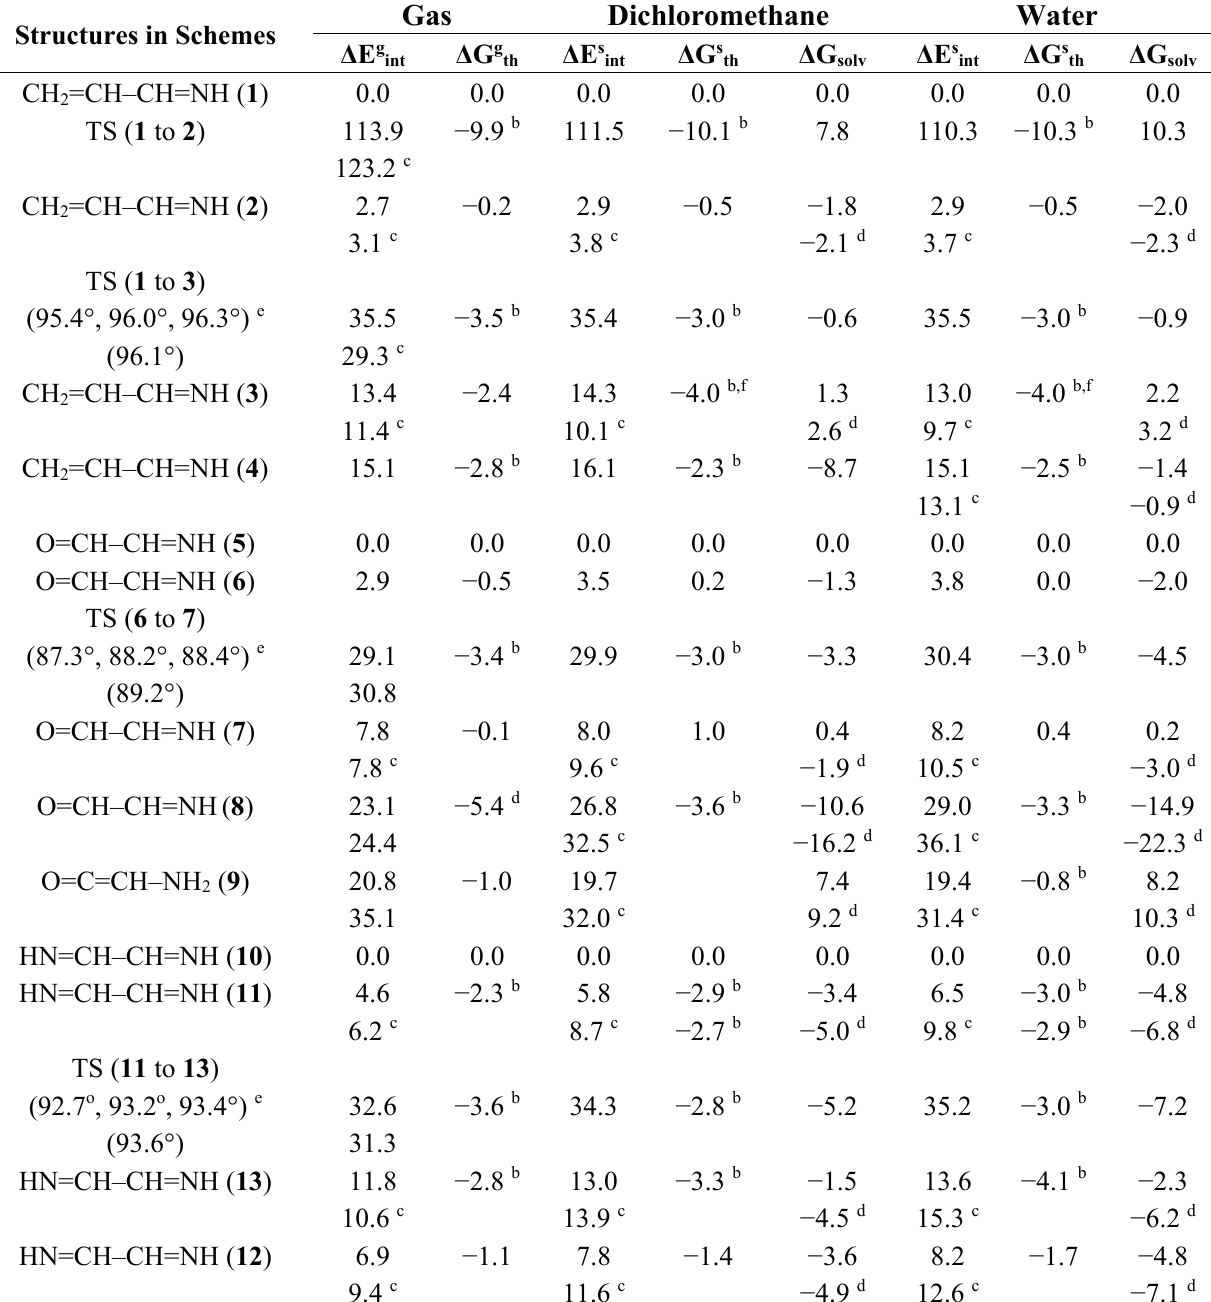
Table 1. Relative energy/free energy components for tautomeric/conformational isomers a . Structures in